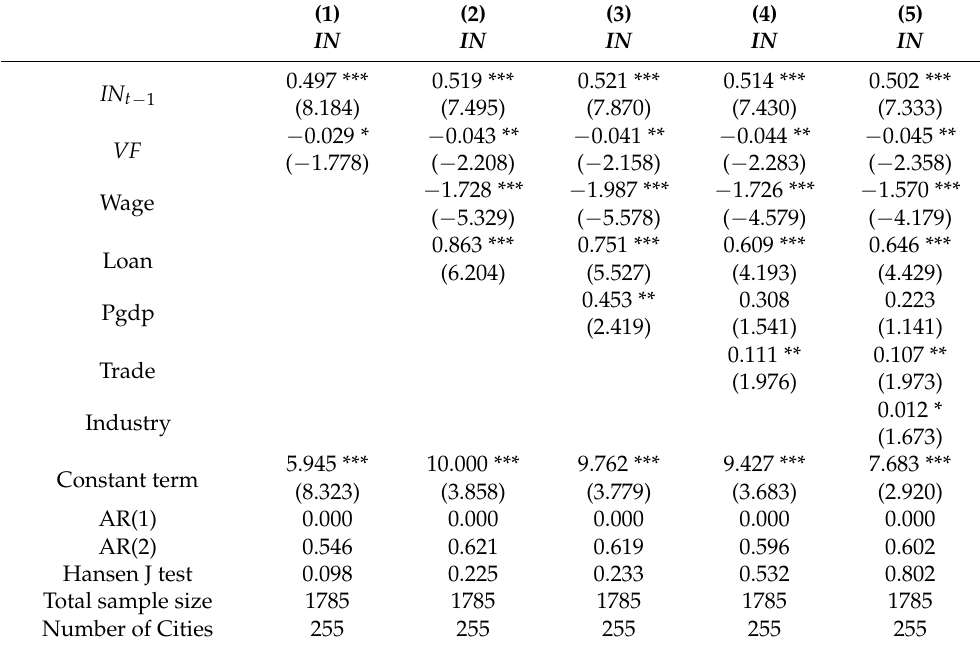
Table 2. Baseline regression